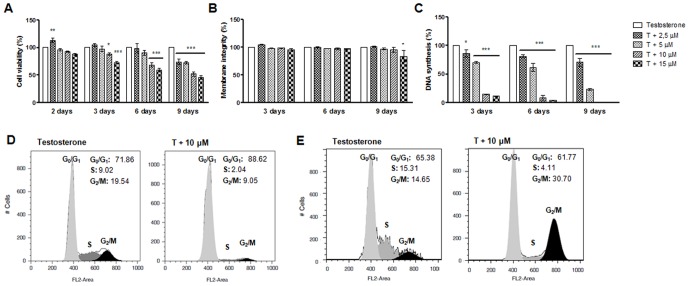
Effects of exemestane on MCF-7aro cells viability, membrane integrity, rate of DNA synthesis and on cell cycle distribution.To study cell viability (A, B) and cell proliferation (C), cells were treated with different concentrations of exemestane for different times. Cells cultured with T represent the maximum of cell viability and cell proliferation and were considered as control. To study cell cycle distribution cells were treated with exemestane during 3 (D) and 6 (E) days and subjected to flow cytometric analysis after PI staining. Data presented in histograms were analysed with FlowJo Software (Tree Star, Inc) by the application of the Watson mathematical model and are representative of one independent assay. Results are the mean ± SEM of three independent experiments, performed in triplicate. Significant differences between the control and cells with exemestane are denoted by * (p<0.05) and *** (p<0.001).